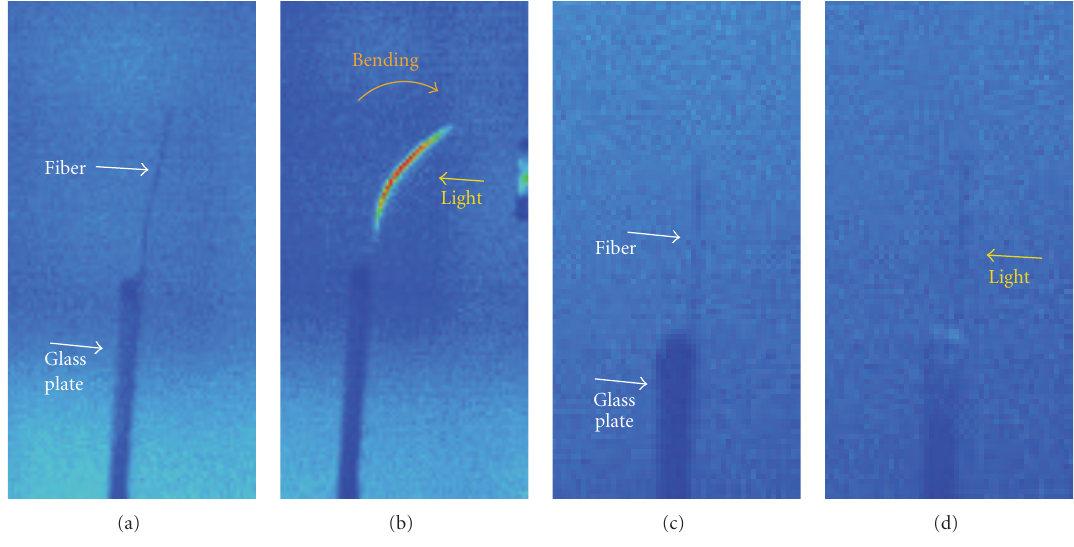
Figure 1: Thermographic images of the PAA/MB fiber (a) before and (b) after illumination, and the PAA fiber (c) before and (d) after